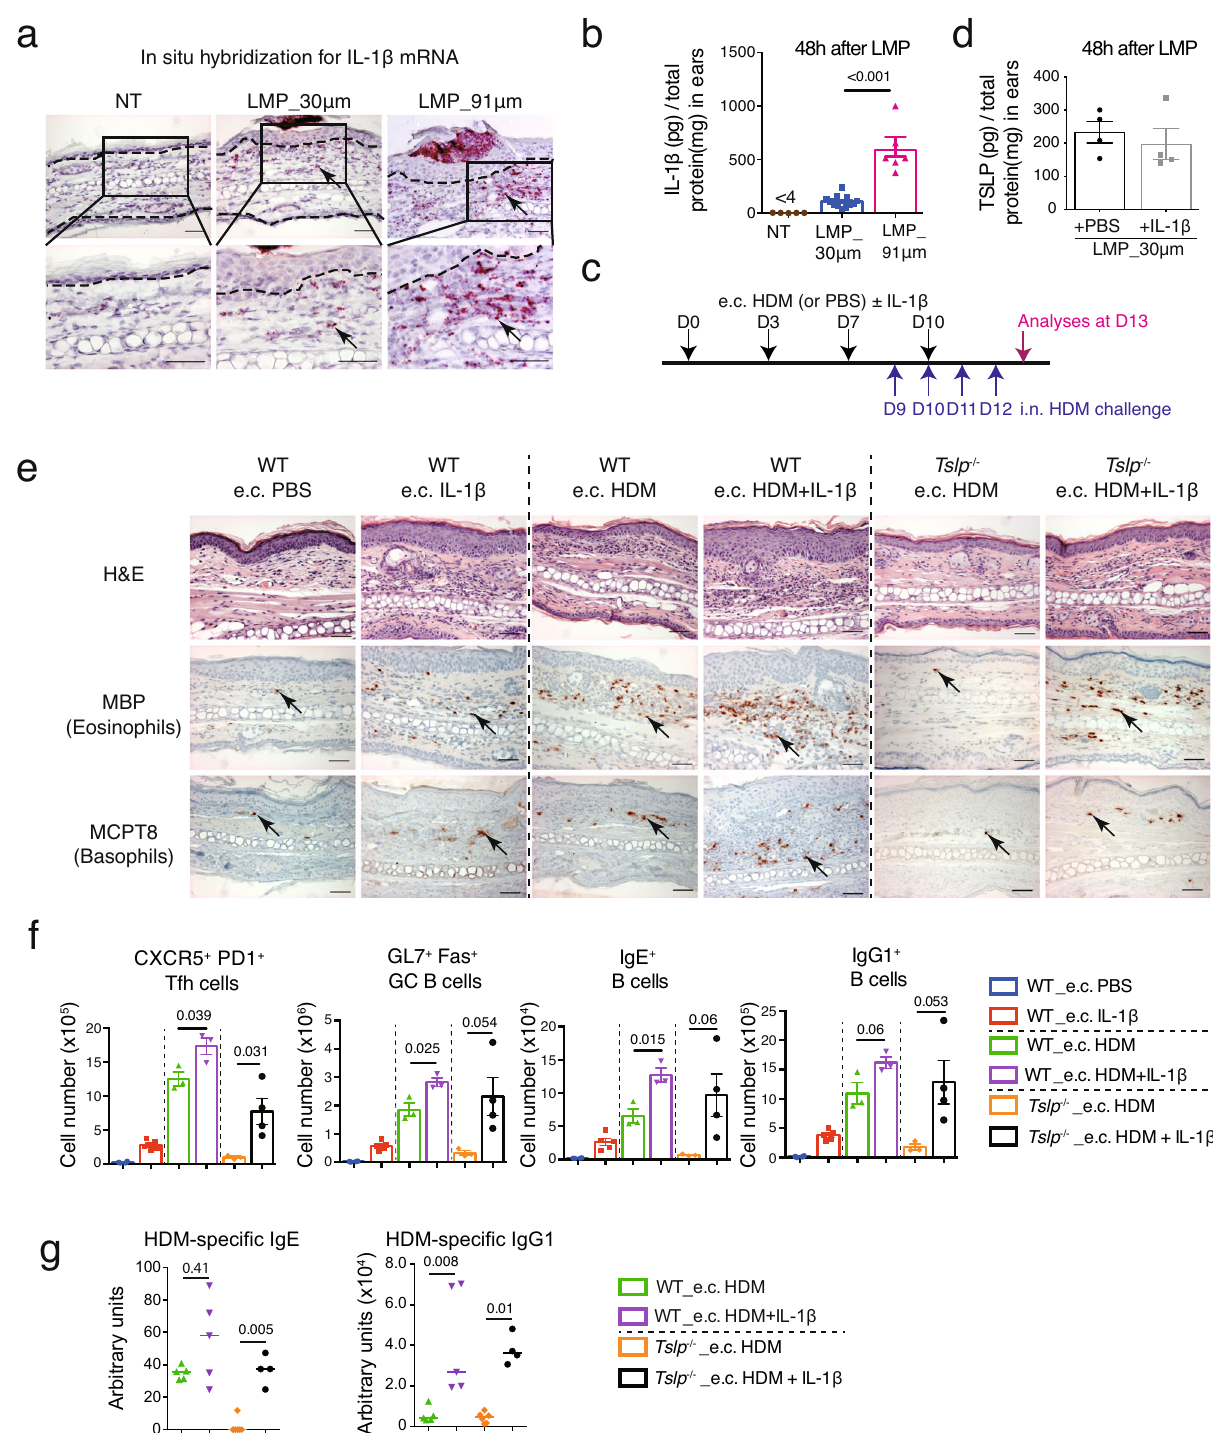
Fig. 3 | Co-administration of IL-1 β enhances e.c. HDM-induced Th2/Tfh responses in a TSLP-independent manner. a RNAscope in situ hybridization for IL-1 β mRNA in non-treated (NT), LMP_30 μ m and LMP_91 μ m ears at 48h after the microporation. Dashed lines indicate the dermal/epidermal junction. b ELISA measurement of IL-1 β protein levels in ears at 48h after LMP_30 μ m and 91 μ m ( n =5,12,6 mice). c Experimentalprotocol.HDM with or without IL-1 β wasapplied on LMP_30 μ m ears (e.c. HDM±IL-1 β ), at day (D) 0, D3, D7 and D10. Mice were intranasally (i.n.) challenged with HDM everydayfromD9to D12 to induceallergic asthma,andanalysedatD13. d ELISAmeasurementofTSLPproteinlevelsin30 μ m-